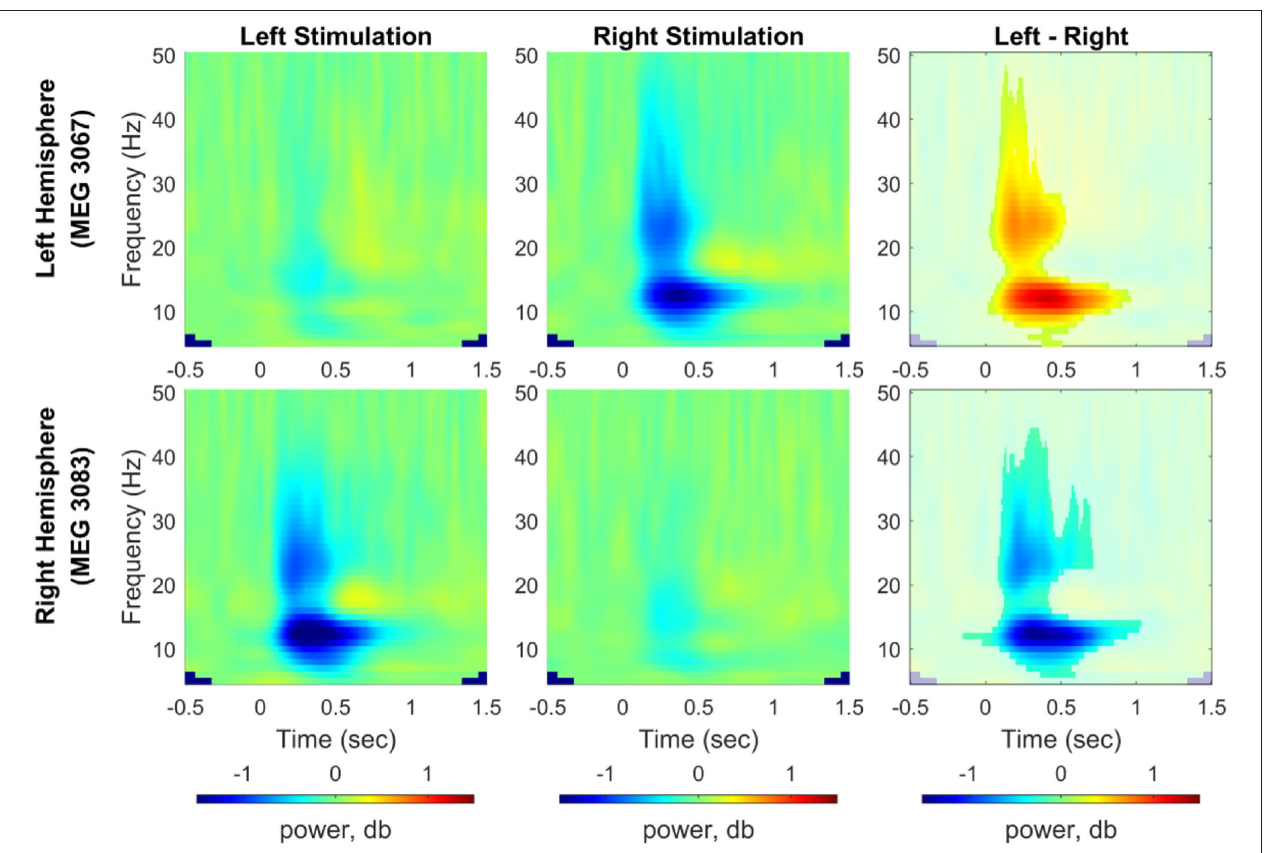
FIGURE 5 | Time-frequency representation of spectral power change induced by vibrotactile stimulation. Grand averaged spectral power change relative to baseline obtained from representative channels from each hemisphere (MEG 3067 for the left hemisphere and MEG 3083 for the right hemisphere) was plotted for the left index finger stimulation condition (left panel) and for the right index finger stimulation condition (middle panel), respectively. In the right panel, power differences between left and right stimulation conditions associated with a significant cluster are shown non-blurred ( N = 29, cluster-based permutation test, 1,000 runs, a significance level of 0.05). Blue color indicates power suppression relative to the baseline for each stimulation condition in the left and center panels, whereas it indicates lower spectral power for the left index finger stimulation compared with the right index finger stimulation (see Supplementary Figures S4 – S7 for results from all MEG